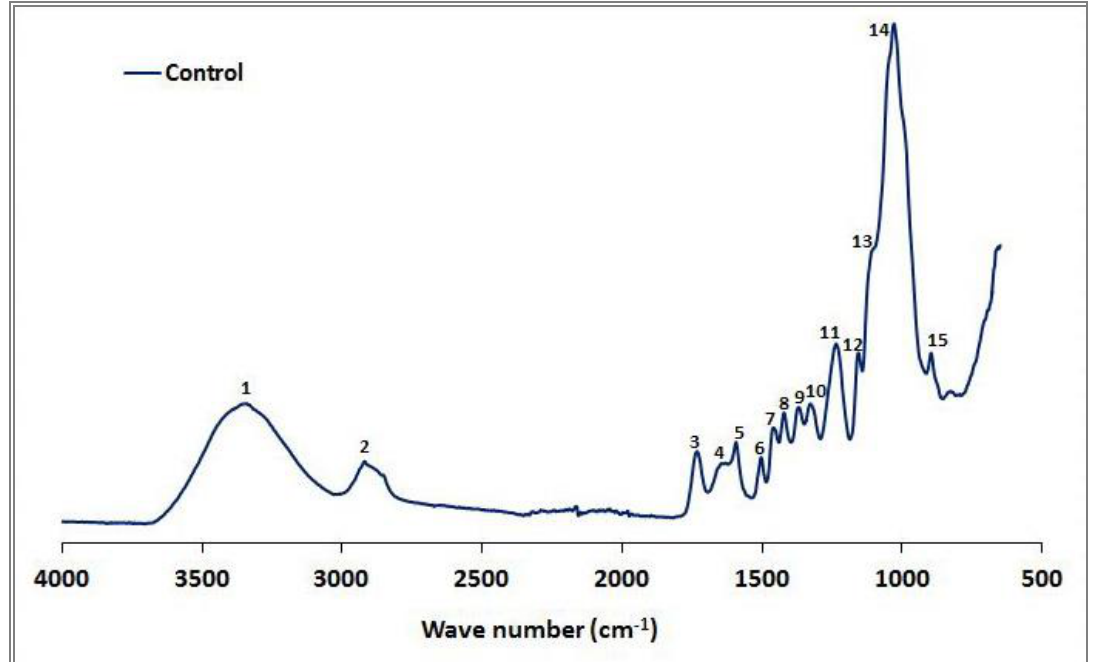
Figure 1. The IR spectra of the control beech wood.